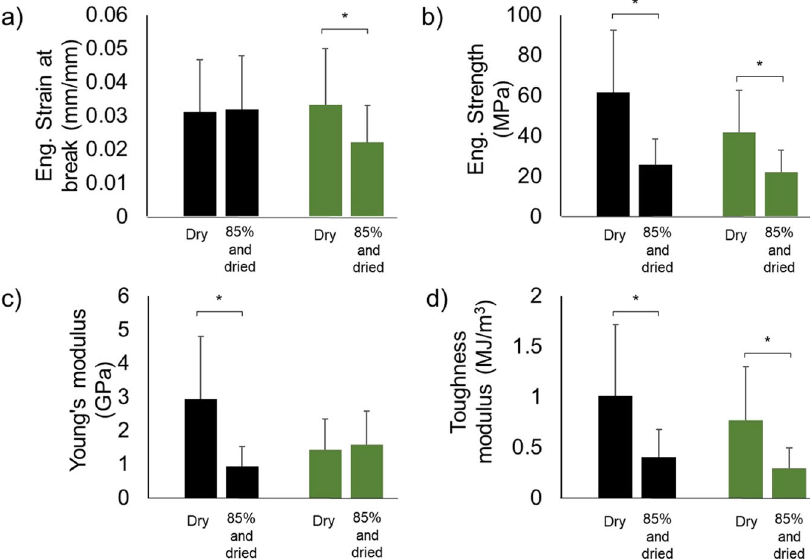
Fig. 5 Mechanical properties of dry and supercontracted fi bers. a Eng. Strain at break, b Eng. Strength, c Young ’ s modulus, and d toughness modulus of fi bers that are as spun (dry) or have been supercontracted at 85% relative humidity while restrained in one end, then dried (at 35% relative humidity) and subsequently tested. Asterisks above the histograms indicate signi fi cant differences ( p value <0.05). The color green is used for the NT2Rep Y-F CT and the color black for the NT2RepCT. The error bars are the standard deviation of the data set.